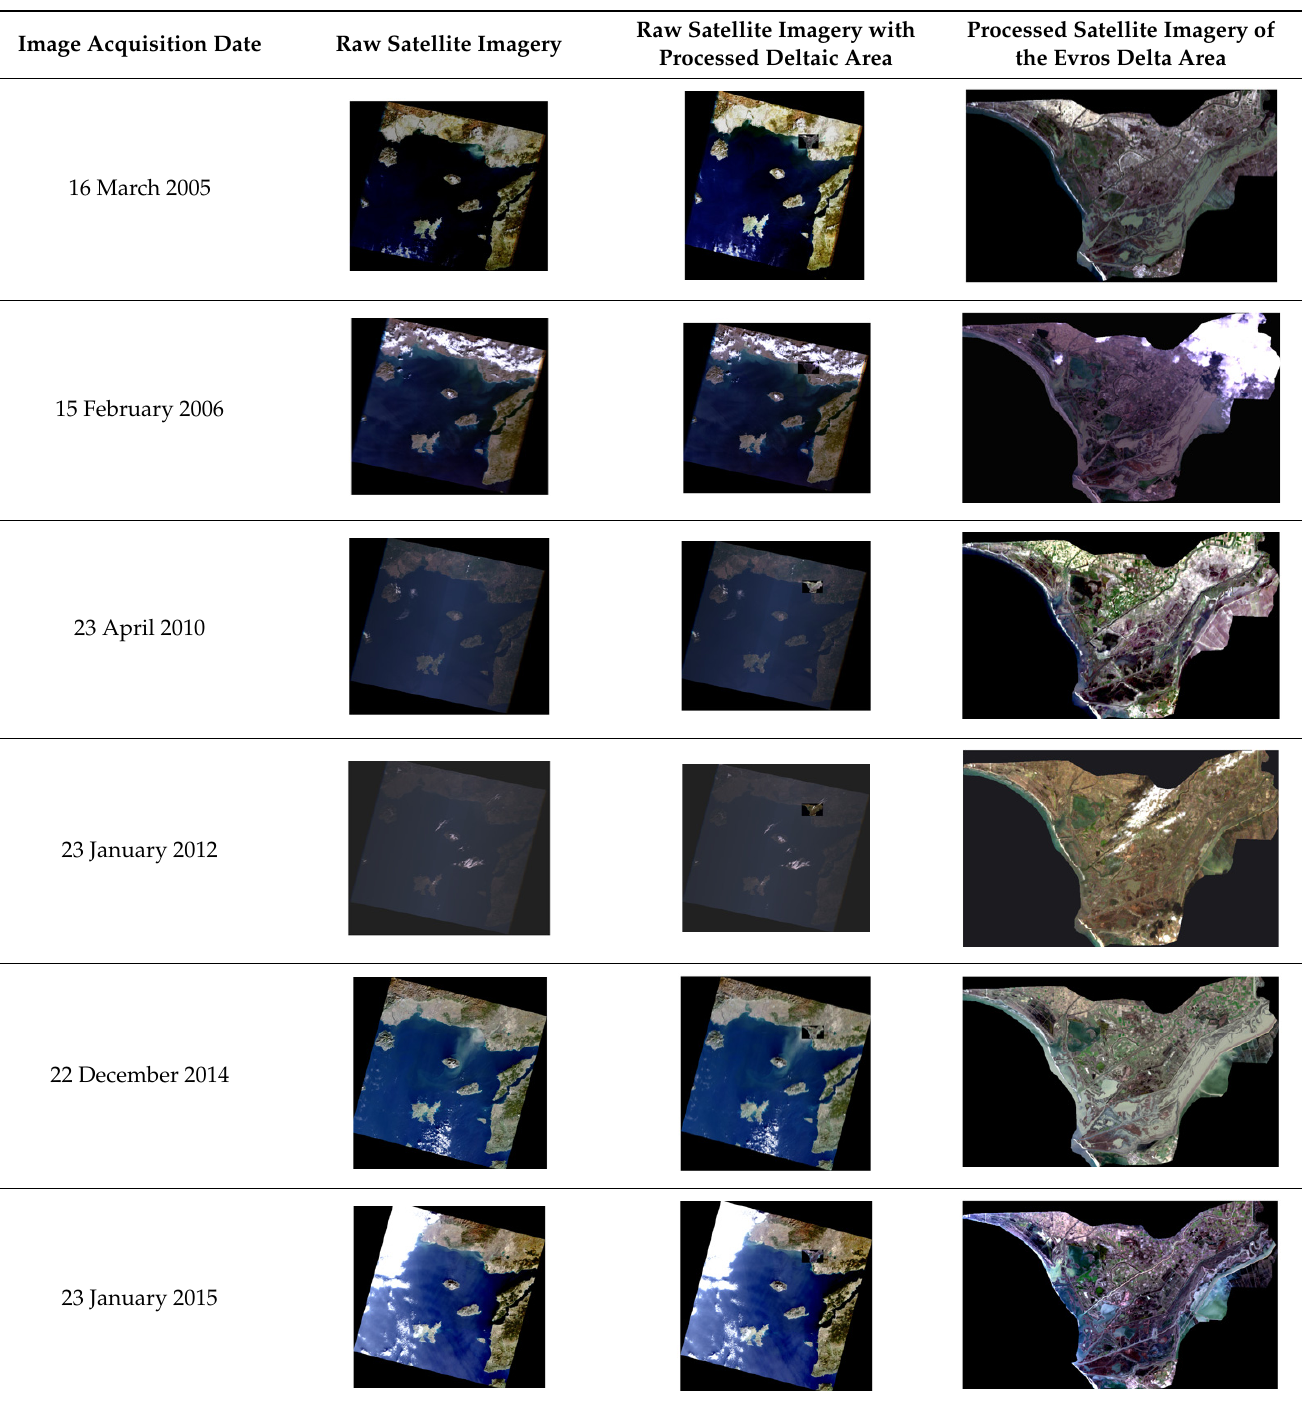
Table A1. Satellite images used in the study.